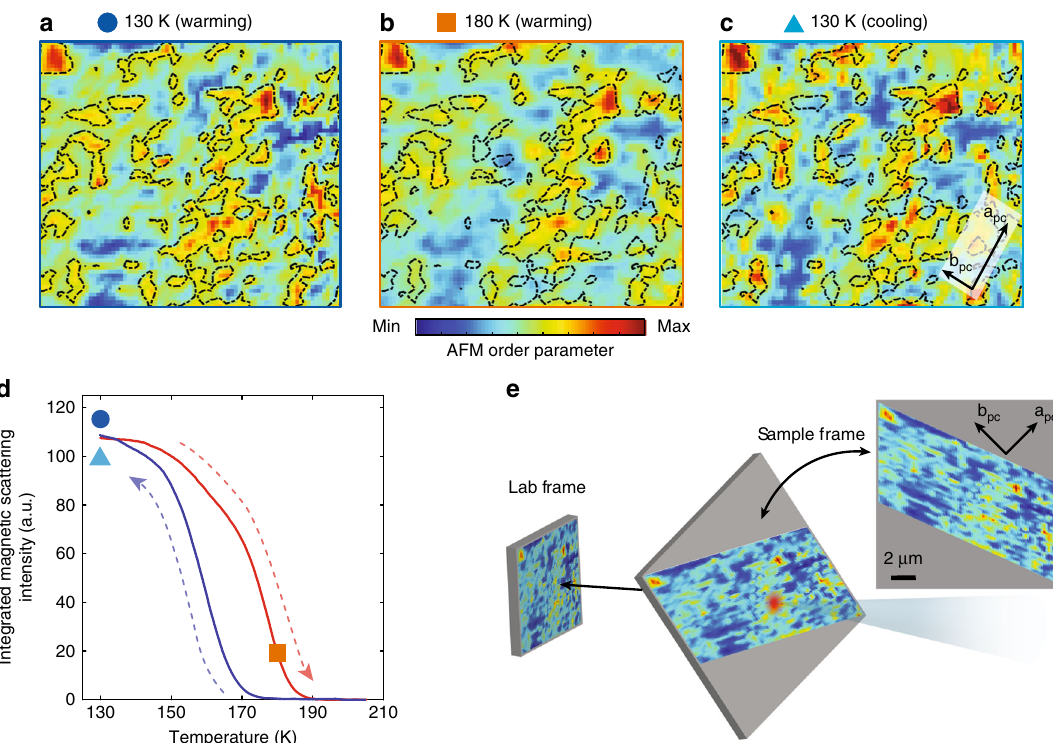
Fig. 2 Magnetic texture vs. temperature. a – c Evolution of the spatial AFM order parameter (square root of scattering intensity) during a thermal cycle across T Néel at temperatures corresponding to the plot markers in ( d ). Min/max color scales are speci fi c to each map. Black dashed contours outline the AFM domains at 130 K (warming cycle ( a ) and are also overlaid in ( b ) and ( c ) to highlight the evolution. The a pc and b pc crystallographic axes are indicated in ( c ); the arrow length corresponds to 1 μ m in the sample frame. d Temperature dependence of the [¼, ¼, ¼] pc AFM Bragg peak intensity, measured using a macroscopic X-ray beam, shows a typical fi rst-order like hysteresis [red (blue) curve is the warming (cooling) cycle]. The temperatures of maps a – c are marked out as well. e The projected AFM landscape map on the sample surface. Note that the measured sample area is not square, and the projected shape, size, and orientation of the AFM domain landscape are shown in the top right